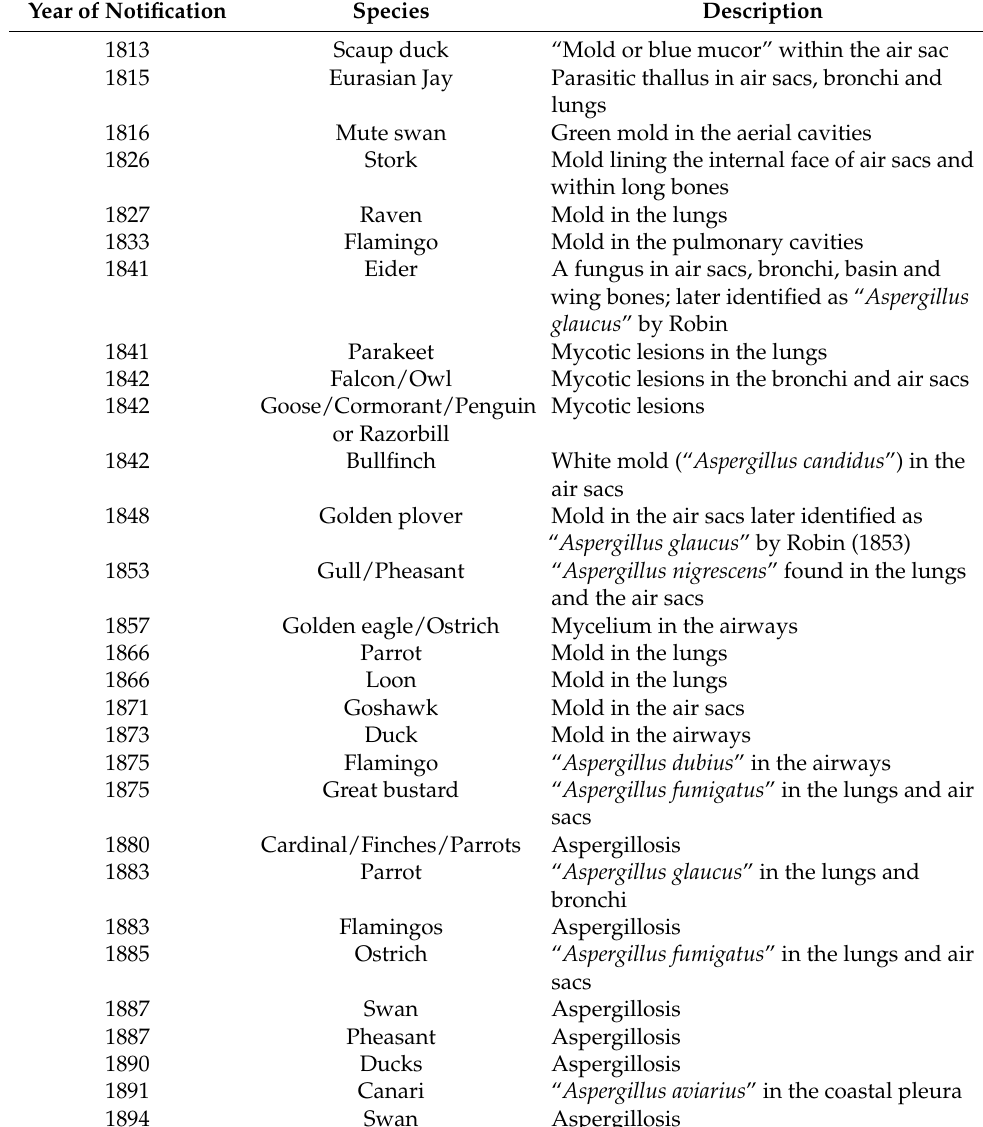
Table 1. First descriptions of mycotic diseases in birds (Urbain and Guillot,